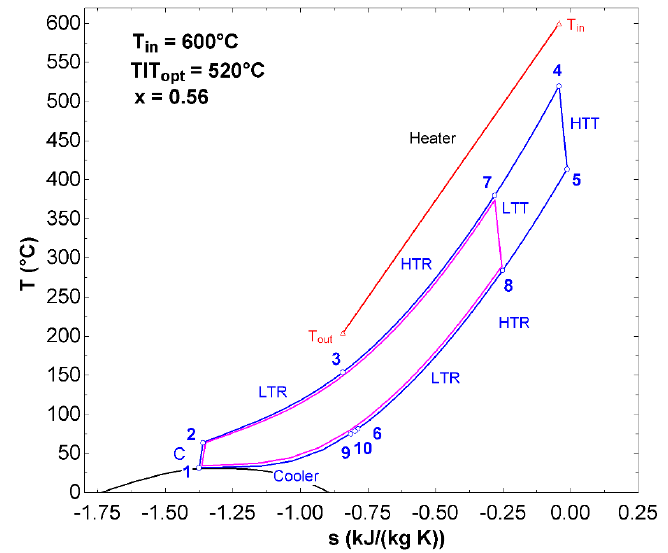
Figure 14. Dual recuperated layout: T–s diagram of the optimum thermodynamic cycle maximizing η . The cooling profile of the heat source is superimposed. TOT